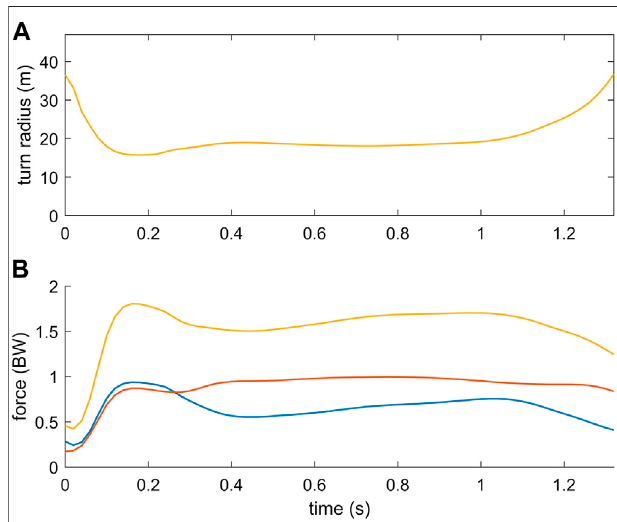
FIGURE 4 | Turn radius of the center of mass of the skier in the turning simulation (A) as well as the total ground reaction force, the ground reaction force acting on the outside ski (red) and inside ski (blue) (B) .